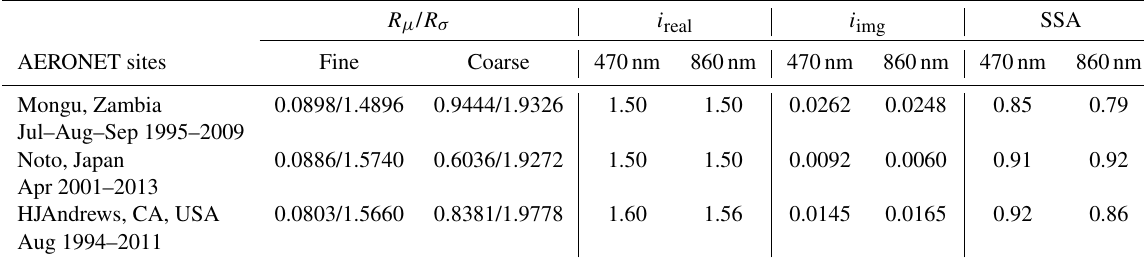
Table 1. Aerosol properties assumed in the simulation of TOA reflectance lookup tables for different events of aerosols above clouds discussed in the text. The assumed microphysical and optical properties were derived from multi-year AERONET measurements at represen- tative sites Mongu (15 ◦ S, 23 ◦ E), Zambia, in southern Africa, Noto (37.33 ◦ N, 137.14 ◦ E) in Japan, and HJAndrews (44.24 ◦ N, 122.22 ◦ W). Notation: R µ / R σ : mean/standard deviation radius of the Gaussian particle size distribution; i real /i img : real/imaginary parts of the refractive index; SSA: aerosol single-scattering albedo. R µ / R σ i real i img SSA AERONET